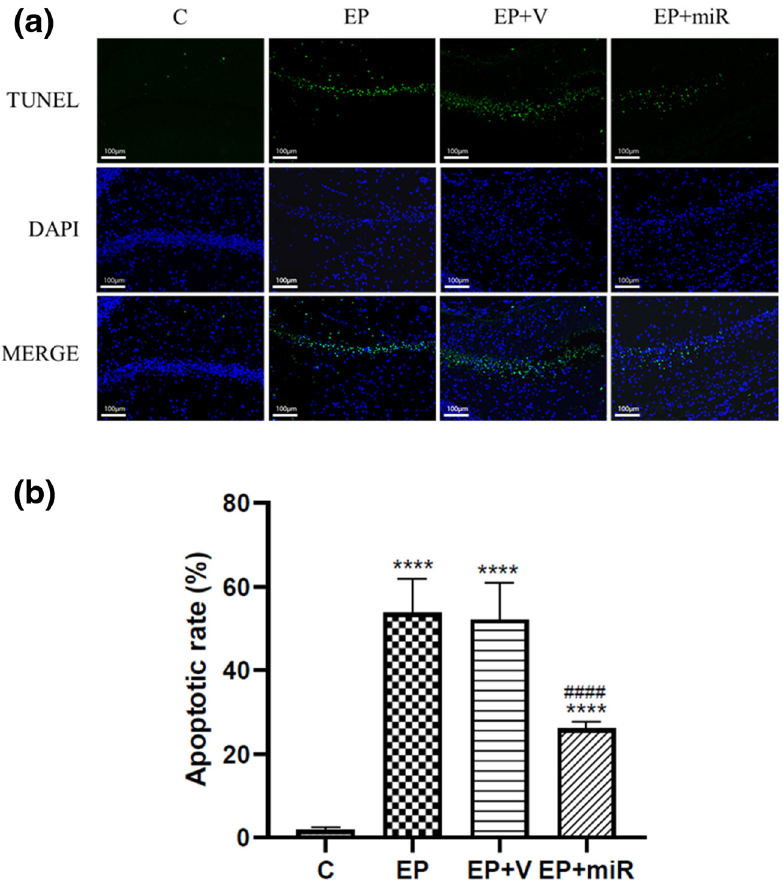
Figure 5: Exogenous miR - 322 - 5p prohibited epilepsy - induced neuronal apoptosis. Notes: ( a ) apoptosis detected by Tunel. Magni fi cation 200 × . ( b ) Quantitative data of the apoptosis. **** p < 0.0001 compared with control; #### p < 0.0001 compared with EP + V group. Abbreviations: C: control, EP: epilepsy, EP + V: epilepsy + vehicle, EP + miR: epilepsy + miR - 322 - 5p intervention